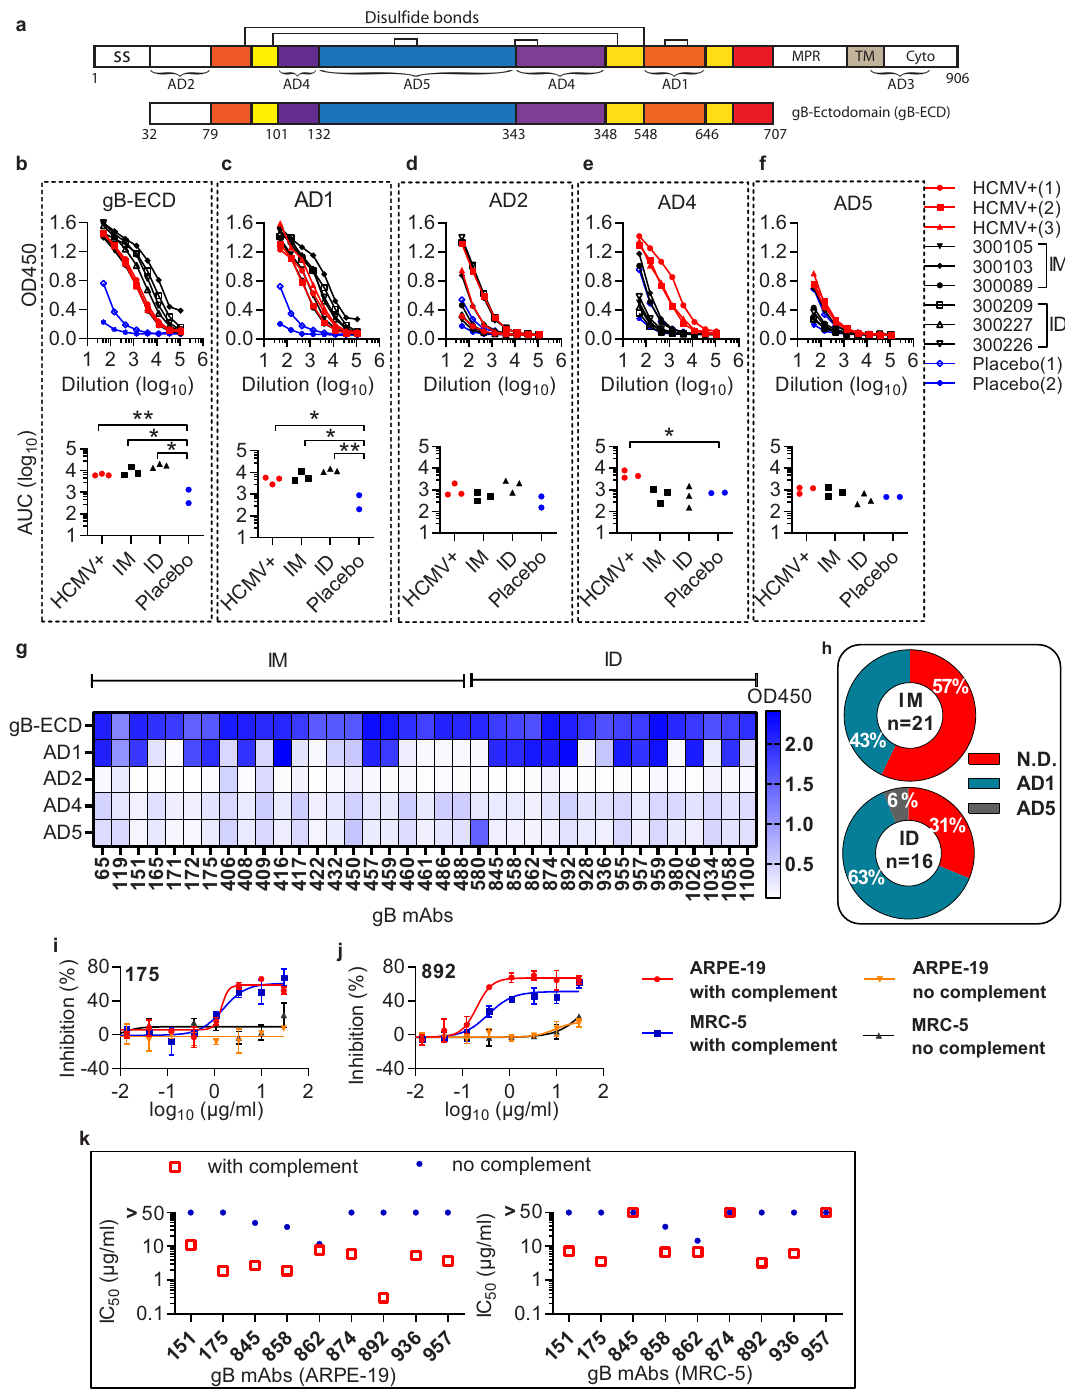
low to AD2 and AD5 domains, with no signi fi cant difference to the placebo control (Fig. 4d, f). However, all three HCMV-positive sera show binding to AD4 domain, at 100 – 1000 dilution, which is not observed in the vaccinated subjects (Fig. 4e). To con fi rm the results, we mapped the puri fi ed 37 gB mAbs to the gB antigenic domains by ELISA. As expected, all the mAbs bind to the gB-ECD protein (Fig. 4g). The most frequent binding site is the AD1 domain (51%, 19 of 37). Only one mAb (mAb 580) binds to AD5, whereas no mAbs bind to the AD2 and AD4 domains (Fig. 4g). The remaining 45% (17 of 37) of gB mAbs did not bind to Published in partnership with the Sealy Institute for Vaccine